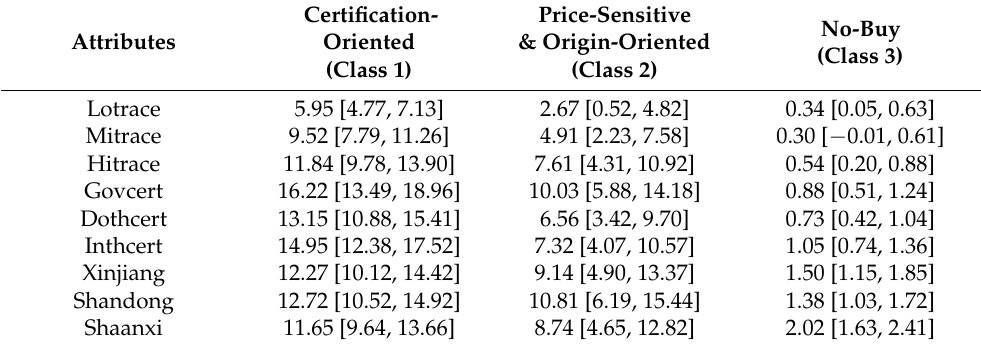
Table 6. WTP estimates of each